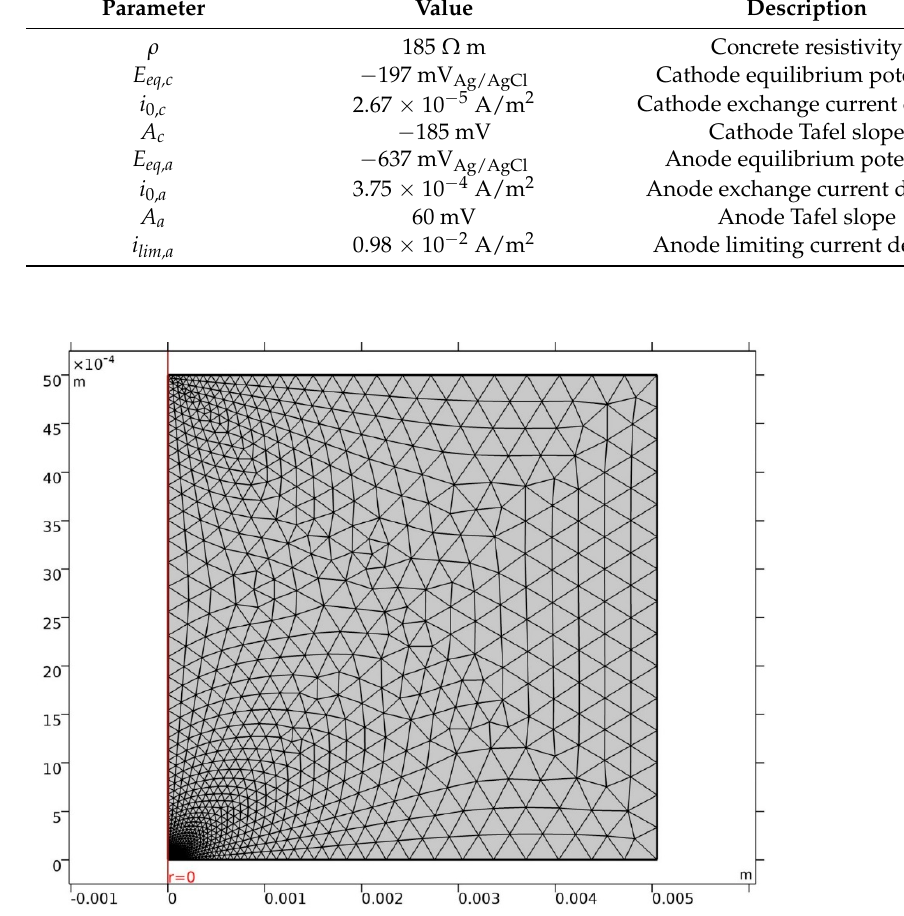
Figure 2. Mesh used.